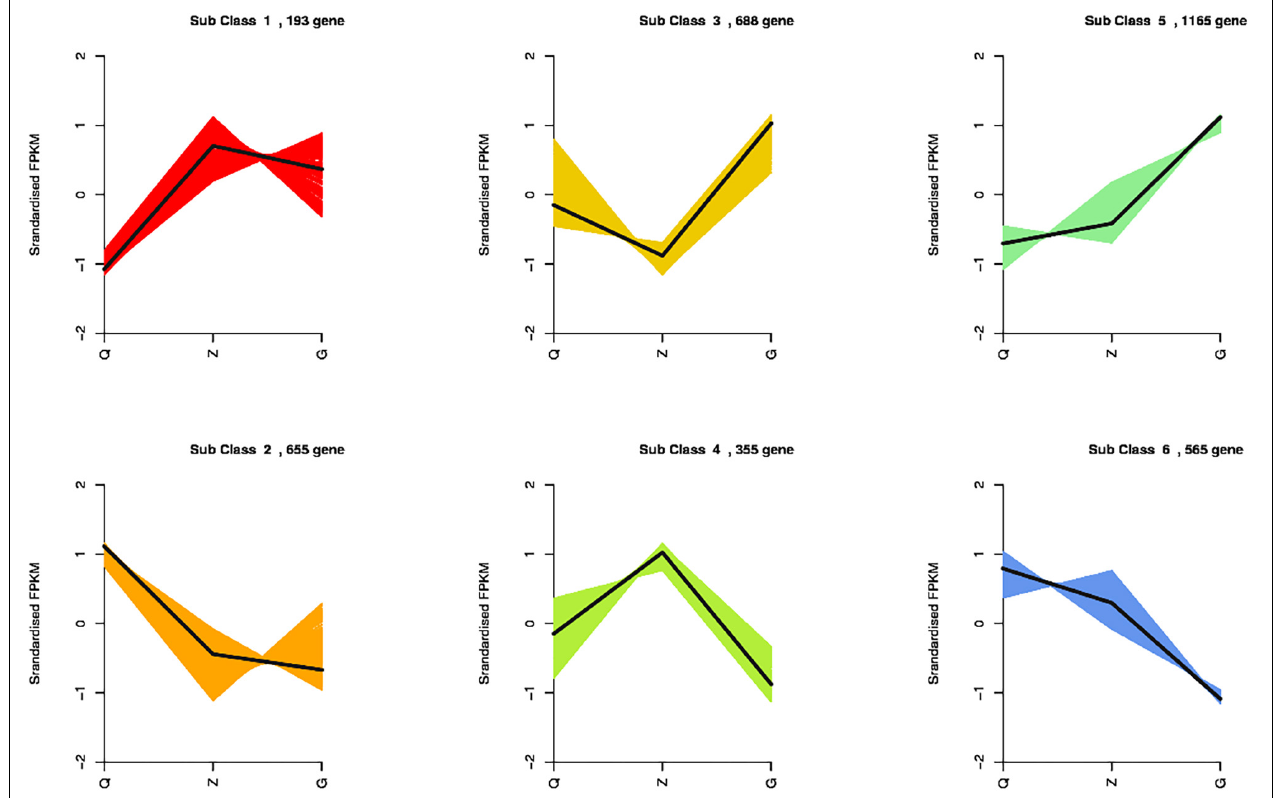
FIGURE 5 | K -means clustering analysis of the DEGs into six clusters according to their expression profiles. The cluster names and the number of unigenes for each cluster are